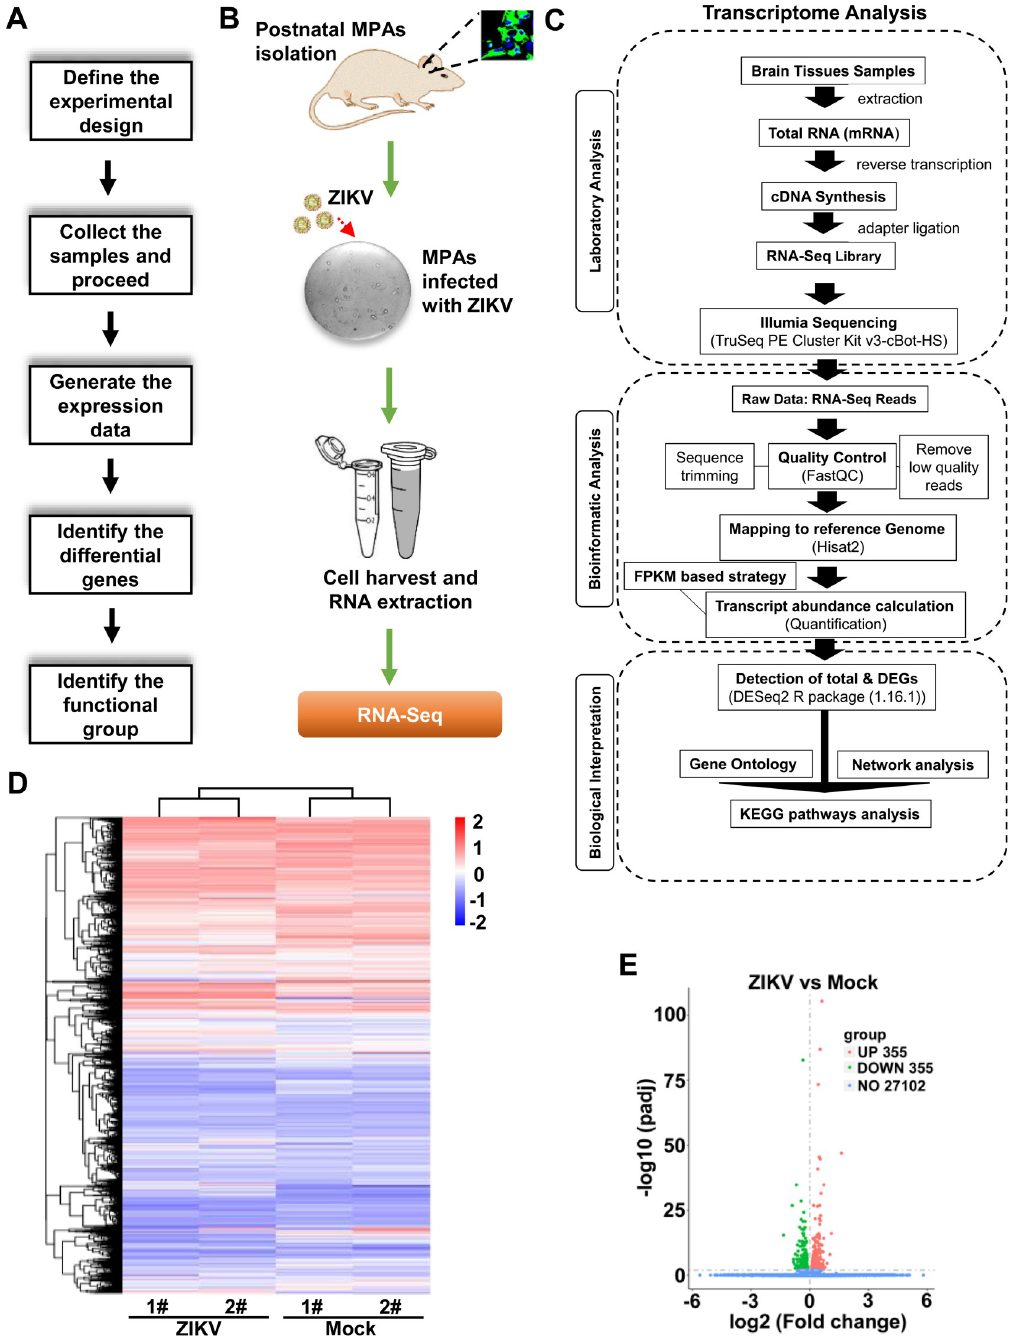
Fig 2. Expression profile for altered mRNAs upon ZIKV infection in MPAs. (A ) A basic workflow diagram for the differential gene expression profile starting from experimental design to using bioinformatic tools. ( B ) Sketch diagram of main experiments from isolation of MPAs to RNA-Seq. ( C ) Flow sheath of transcriptome analysis of MPAs upon ZIKV infection. ( D ) Hierarchical clustering Heatmap of a distinguishable mRNA expression profiling in mouse primary astrocyte cells of ZIKV-infected group relative to Mock group (each group, n = 2). ( E ) Volcano analysis for a profile of mRNAs expressions of ZIKV-infected relative to Mock group. Red dots illustrate up-regulated genes, green dots represent down-regulated genes, while blue dots show insignificant genes. The underlying numerical data for “Fig 2D and 2E” is provided in the supporting file “S1 Data”.